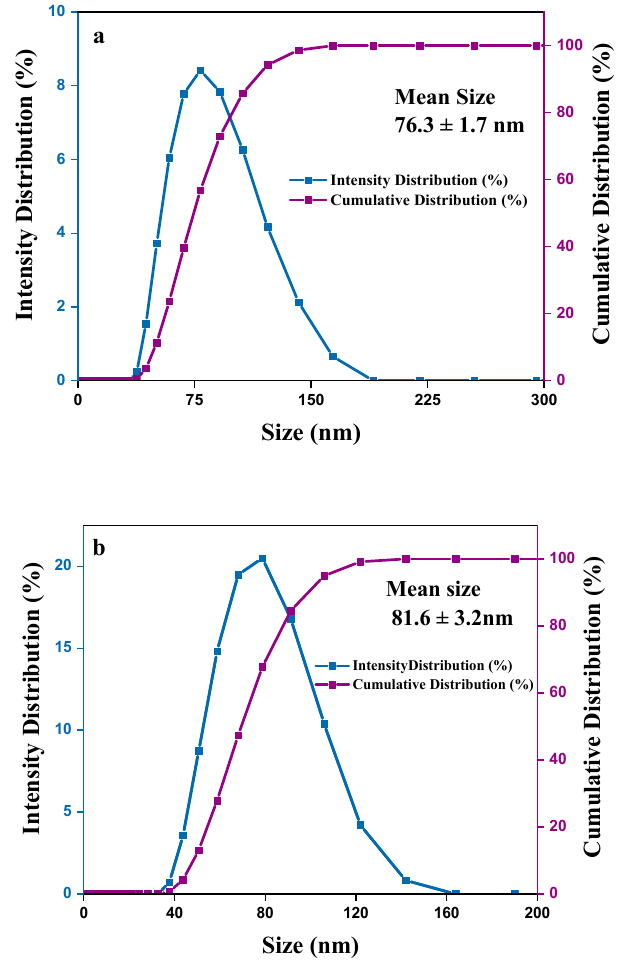
Figure 5. Particles size distribution by the intensity and cumulation of ( a ) sorafenib-loaded chitosan nanoparticles (SF-CS) and ( b ) folate-conjugated sorafenib-loaded chitosan nanoparticles (SF-CS-FA).